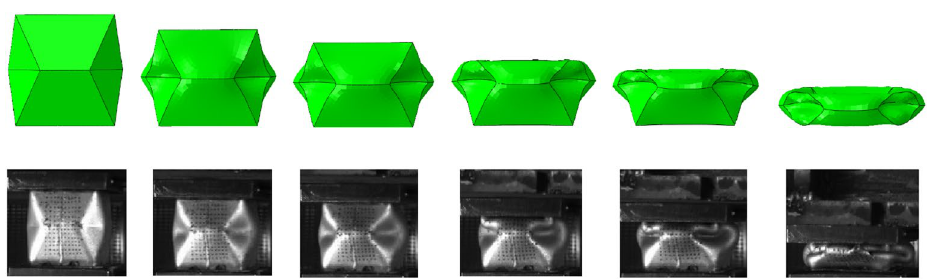
Figure 6. Crushing process diagram of numerical simulation and